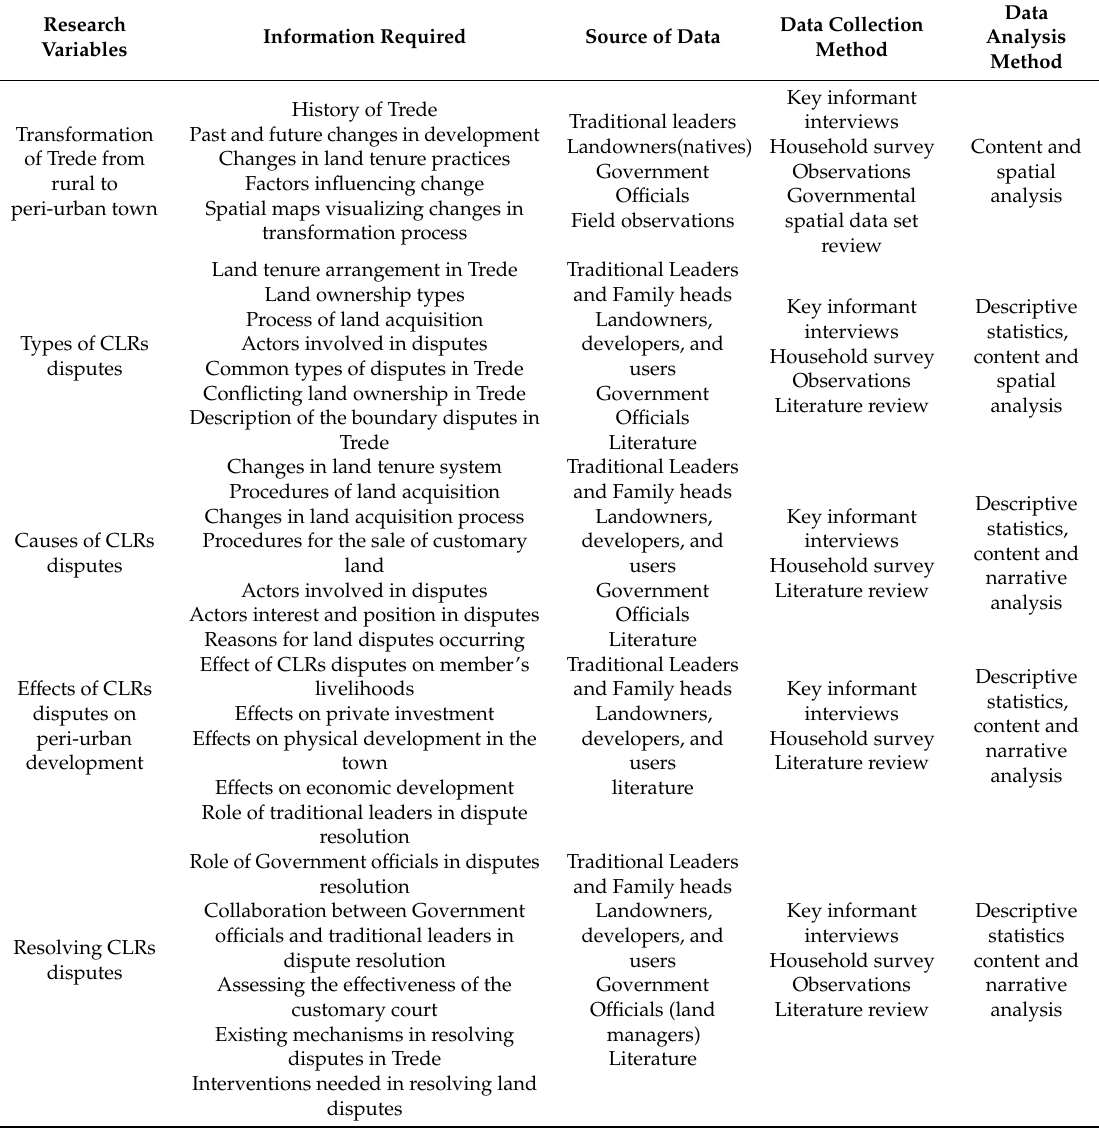
Table A1. Overall research matrix (source: Authors,